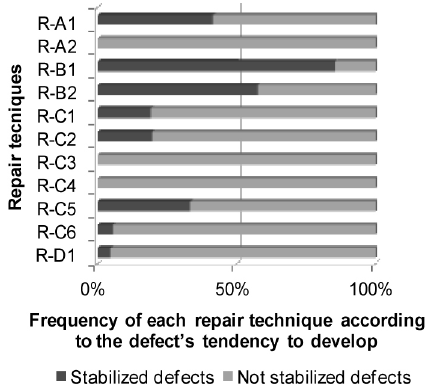
Fig. 16. Frequency of each repair technique according to the defect’s tendency to